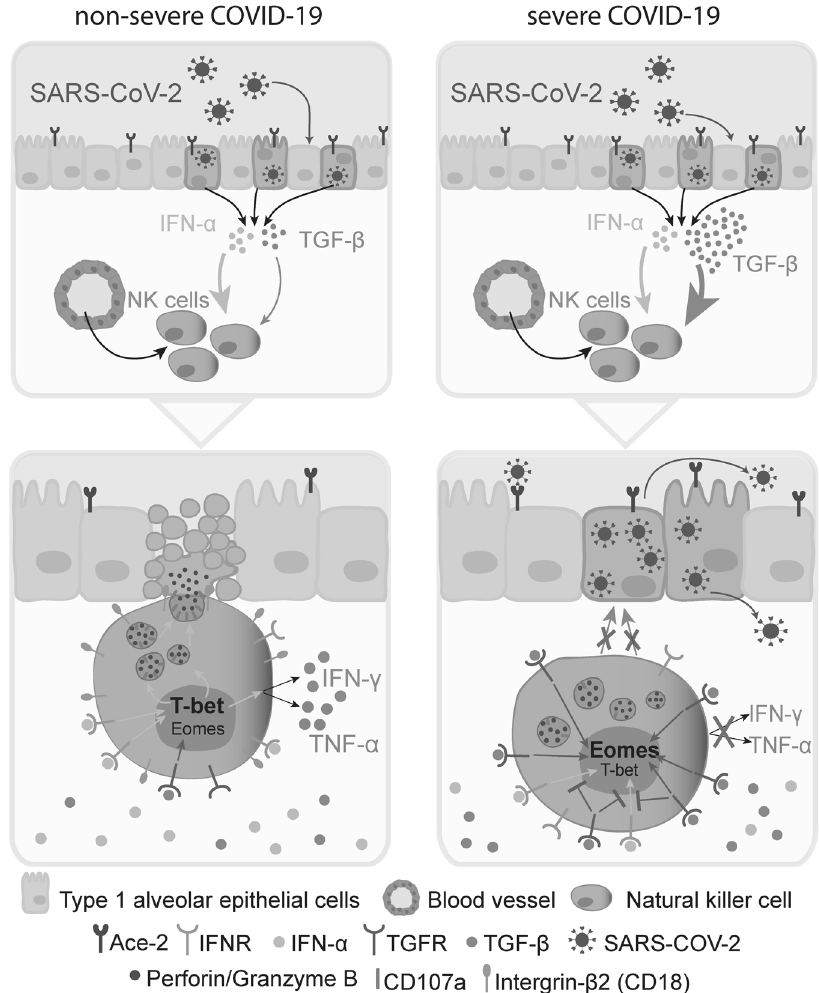
Fig. 1 Production of tumor growth factor-beta (TGF- β ) inhibits the antiviral functions of NK cells in response to SARS-CoV-2 infection. In severe but not in moderate COVID-19 patients, the high TGF- β concentration might be a result of SARS-CoV-2 infection (depicted) and/or co- morbidities. In severe COVID-19 patients, TGF- β is produced by various cell types, including type 1 alveolar epithelial cells (depicted), fi broblasts, myo fi broblasts, and myeloid cells. TGF- β counteracts interferon-alpha (IFN- α )-induced activation of recruited natural killer (NK) cells, impedes T-bet activation, and skews the transcription activity towards Eomes. Consequently, these cells have lower expression of integrin- β 2 (CD18), IFN-gamma (IFN- γ ) and tumor necrosis factor alpha (TNF- α ). Lack of integrin- β 2 molecules precludes fi rm adhesion of NK cells to infected cells, preventing NK cell degranulation and killing of infected cells, thus leading to uncontrolled virus